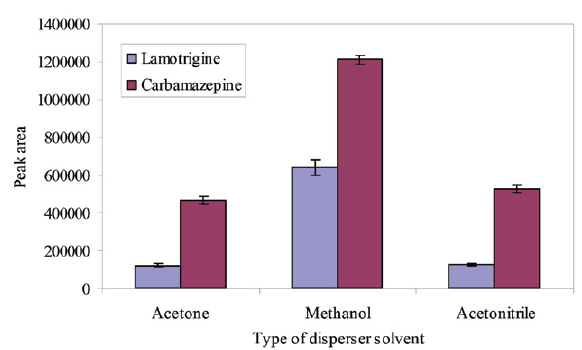
Figure 5. Effect of type of disperser solvent on the extraction effi- ciency, Extraction conditions: extraction solvent: [C8MIM][PF6], extraction solvent volume: 30 µL; dispersive solvent volume: 100 µL; concentration of NaCl ( w/v ): 1.0%, pH:10